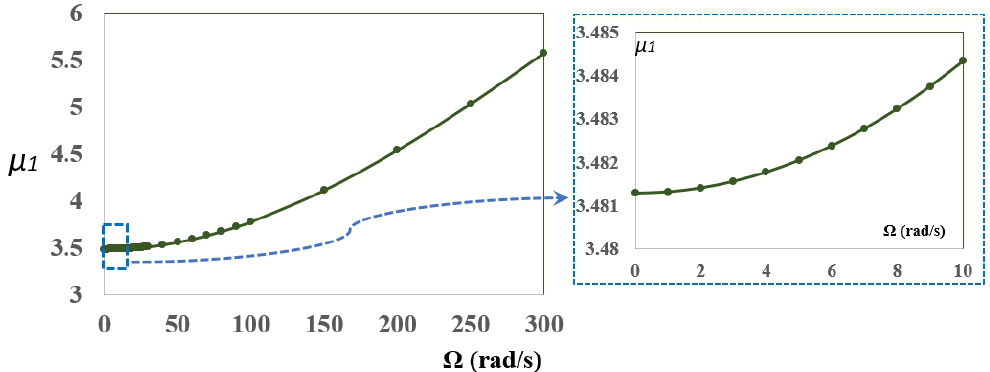
Figure 3. Dimensionless natural frequency, µ 1 , vs. rotational speed Ω for: r = 0.26, ξ c = 0.35, α = 0.22 and S L = 85.